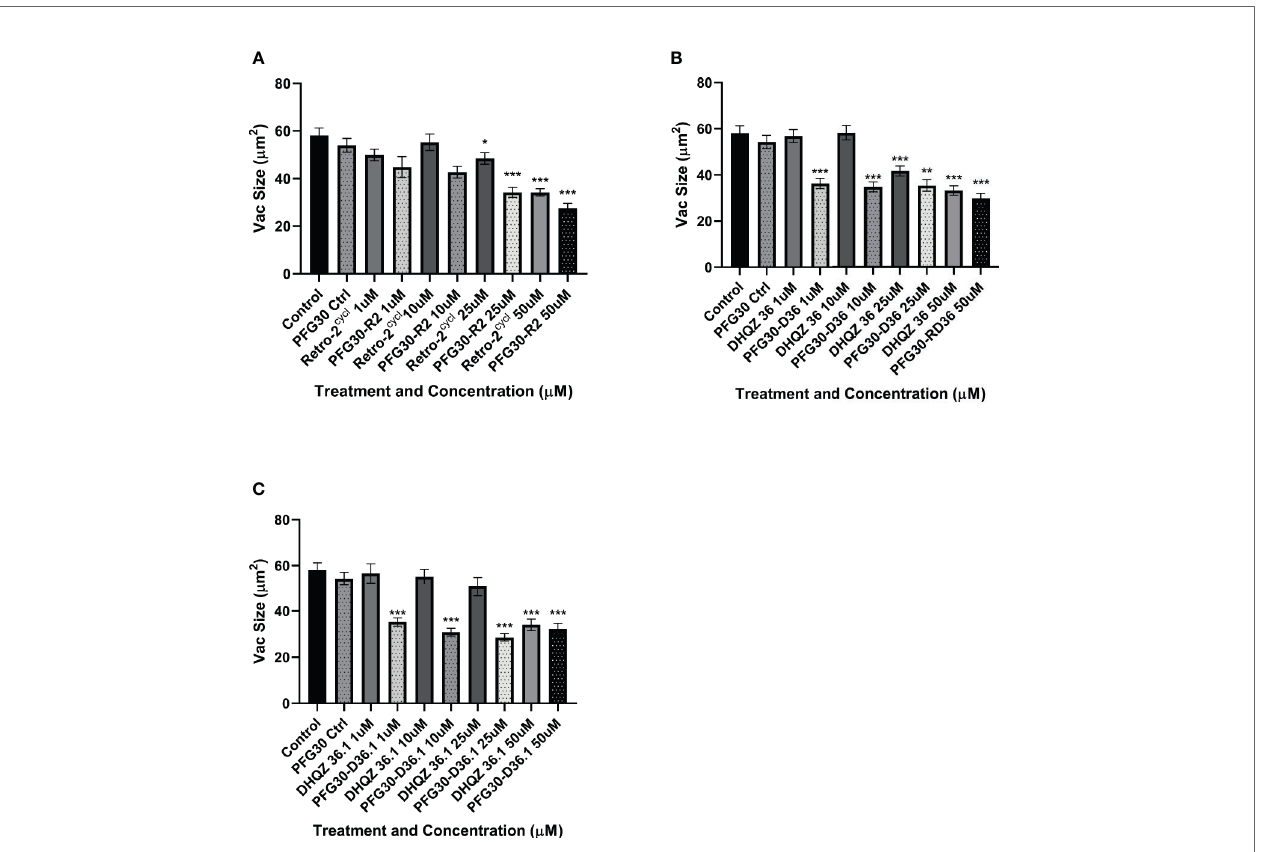
FIGURE 7 | Vacuole size measurements of drug treated L. amazonensis LPVs. RAW264.7 macrophages were infected for 24 h after which they were treated Retro- 2 or DHQZ analogs, with or without encapsulation in PFG30. (A) Treatment with Retro-2 (0 – 50 µM) with or without PFG30 encapsulation. (B) Treatment with DHQZ 36 (0 – 50 µM) with or without encapsulation. (C) Treatment DHQZ 36.1 (0 – 50 µM) with or without PFG30 encapsulation. Data were compiled from three experiments. At least 30 vacuoles were measured per treatment via one-way ANOVA with the S ̌ ı ́ da ́ k correction for multiple comparisons. (*p-value < 0.05, **p-value < 0.01, ***p- value <